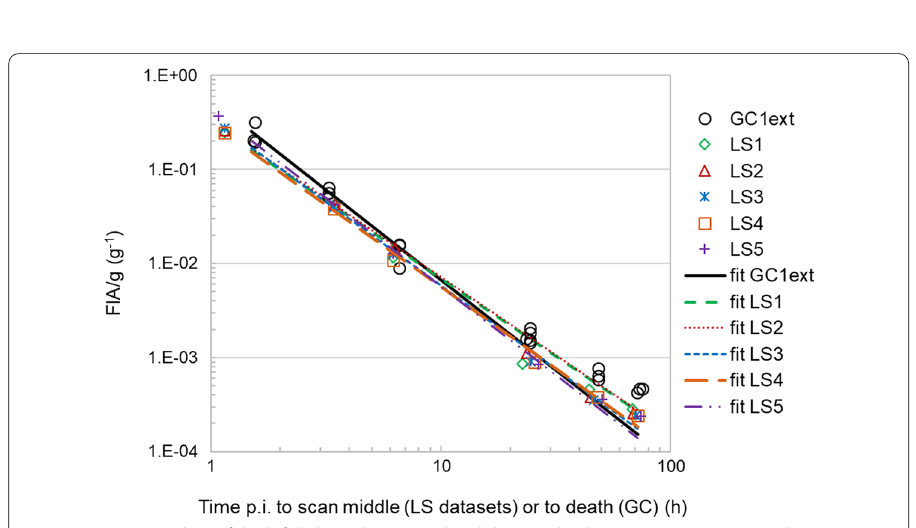
Fig. 7 Time– FIA / g data of the left kidney determined with longitudinal in vivo SPECT imaging (datasets LS1–LS5) and with GC (dataset GC1ext), of, respectively, 5 (SPECT) and 20 (GC) mice injected with the [ 131 I]-labelled sdAb. The curves indicate the power function fit of each dataset (cfr. function coefficients